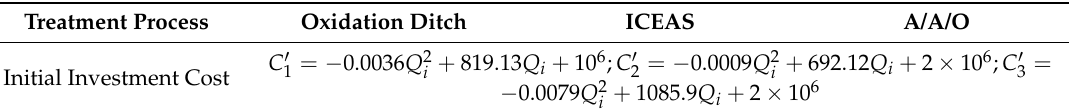
Table 5. Initial investment cost of three types of sewage treatment processes (lv 2009 [37]).